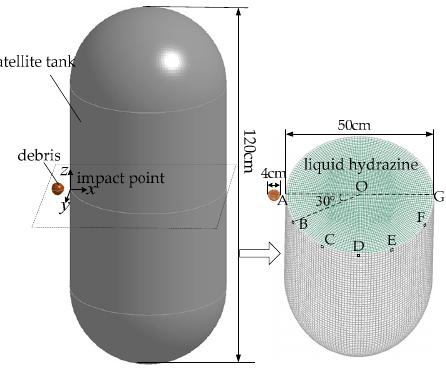
Figure 4. The simulation model of the debris impacting the satellite tank at the velocity of 7000 m/s; the right side is the model cut in half.